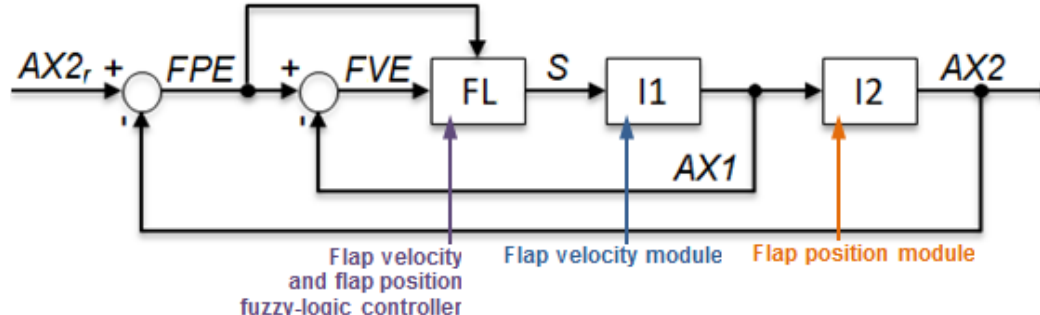
Figure 5. Structural diagram of the developed fuzzy-control